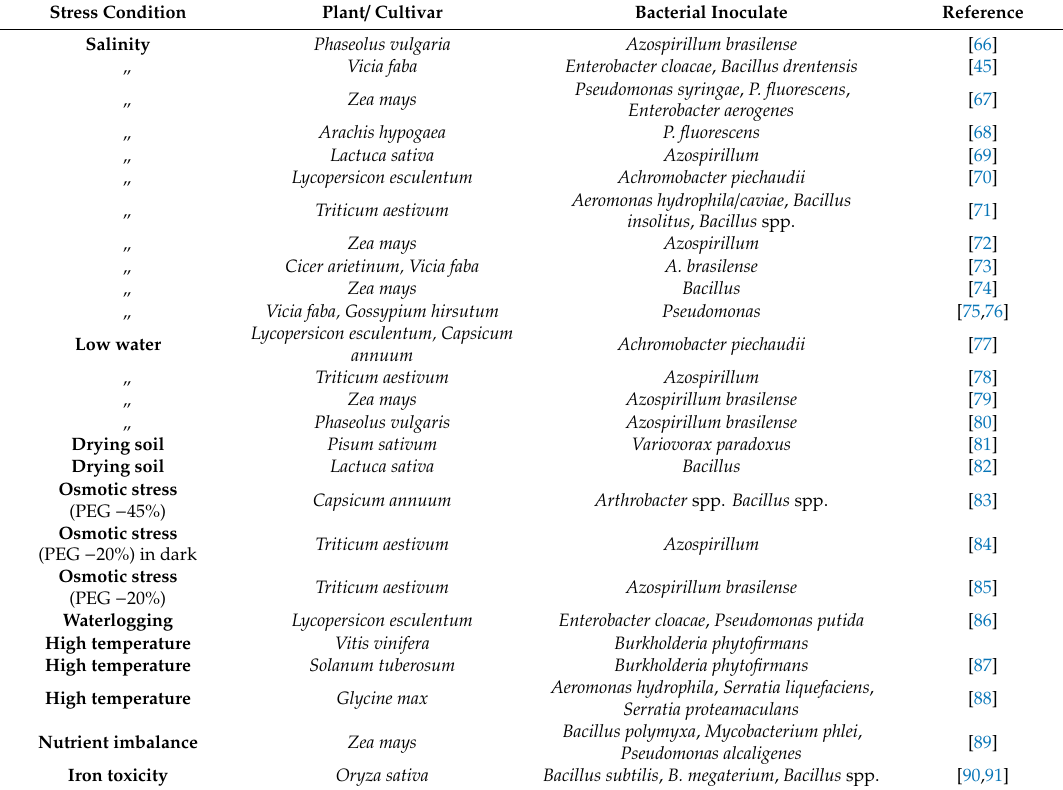
Table 2. Plant–rhizobacteria-mediated plant tolerance to abiotic